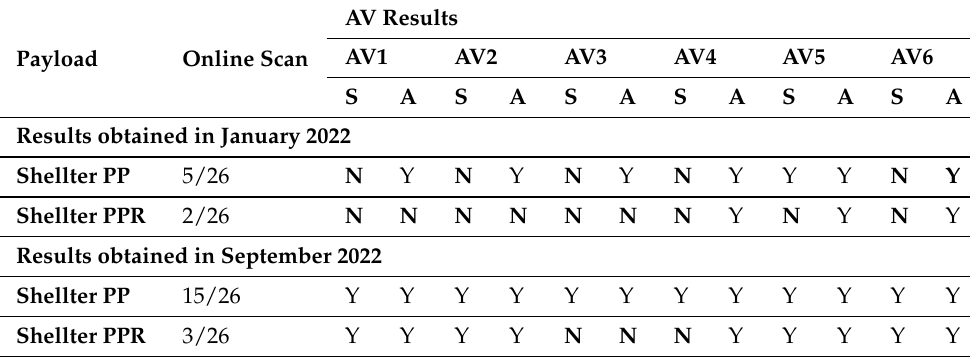
Table 3. Shellter results.